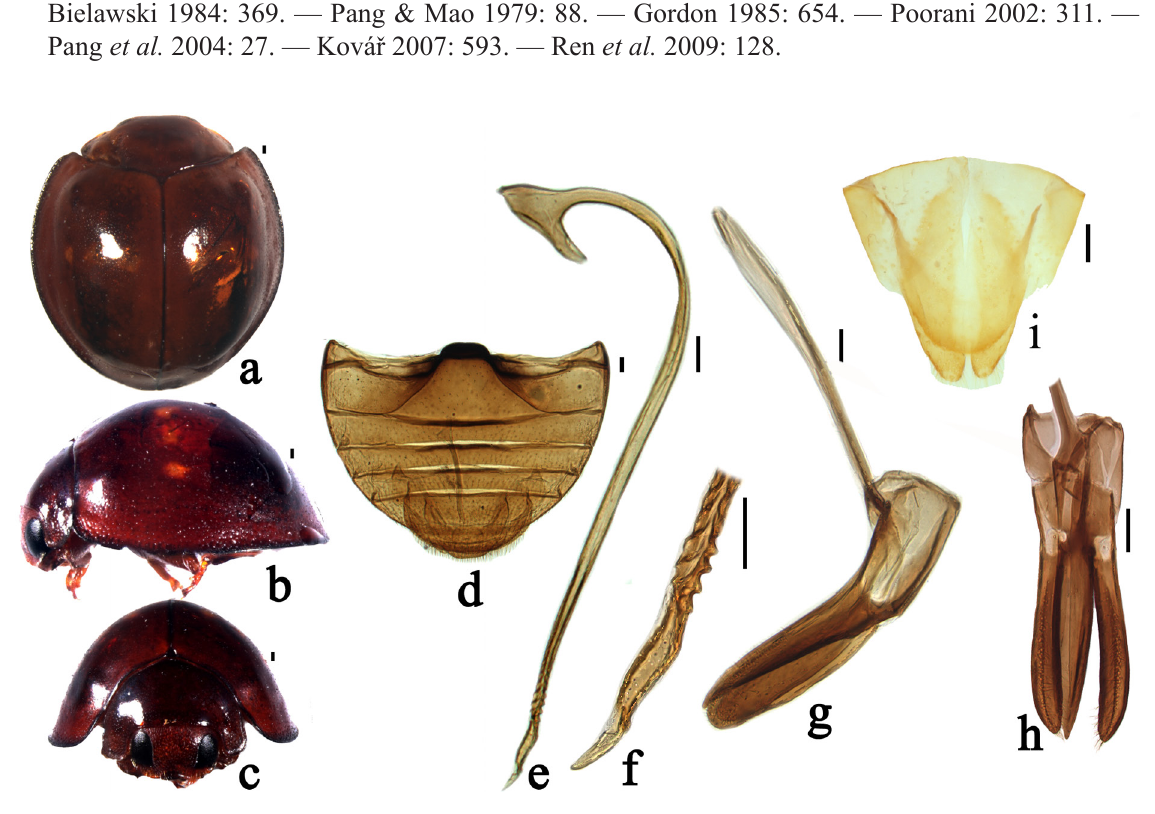
Fig. 19. Chilocorus bipustulatus (Linnaeus, 1758). a . Dorsal view. b . Lateral view. c . Frontal view. d . Abdomen. e . Penis. f . Apex of penis. g . Tegmen, lateral view. h . Tegmen, ventral view. i . ovipositor. Scale bars: 0.1 mm.